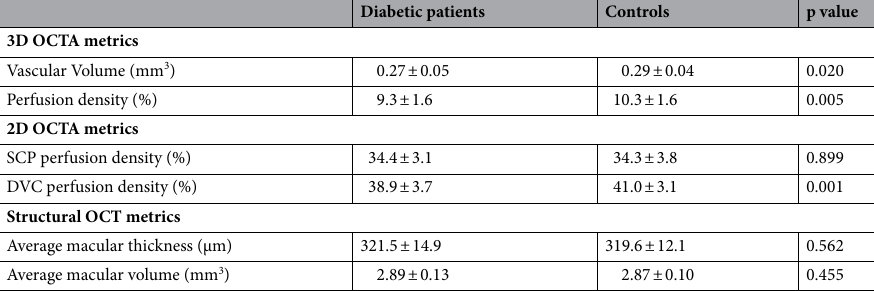
Table 1. Structural OCT and OCTA metrics in diabetic patients and healthy controls. Data are expressed as mean±SD (standard deviation). 2D two-dimensiona, 3D three-dimensiona, OCTA optical coherence tomography angiography, SCP superficial capillary plexus, DVC deep vascular complex.